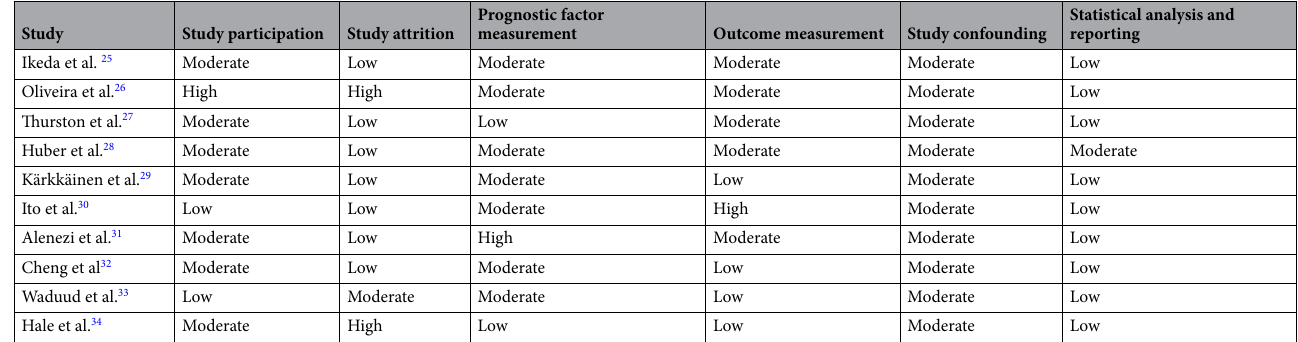
Table 2. Risk of bias summary judgements (from QUIPS tool) for the studies included in the final